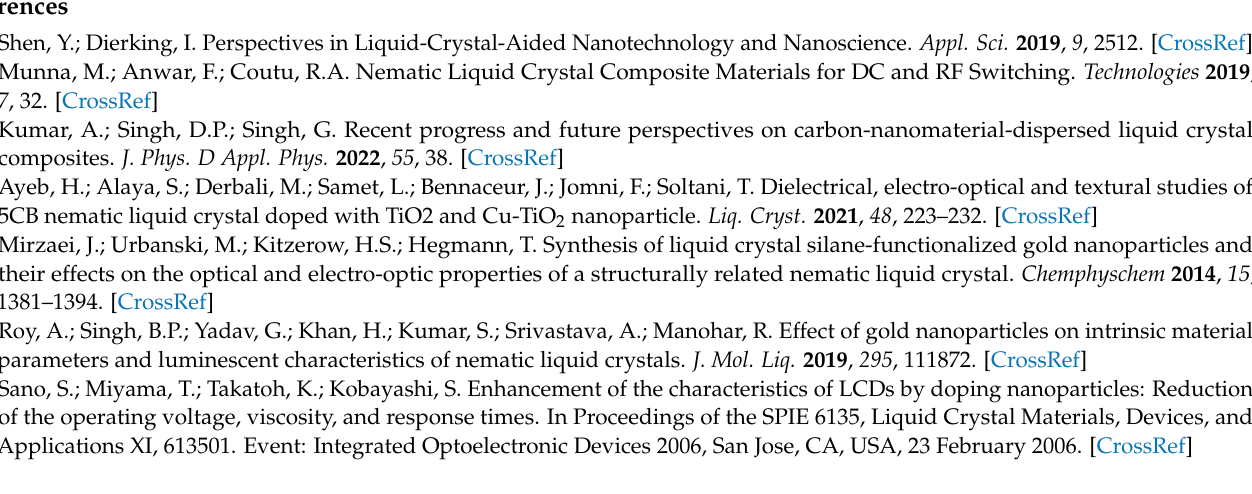
AzoGNPs at 642 nm and 10 kHz. Figure S2: Rotational viscosity CPI measurements vs. OMPA fit of E7 + 1 wt%